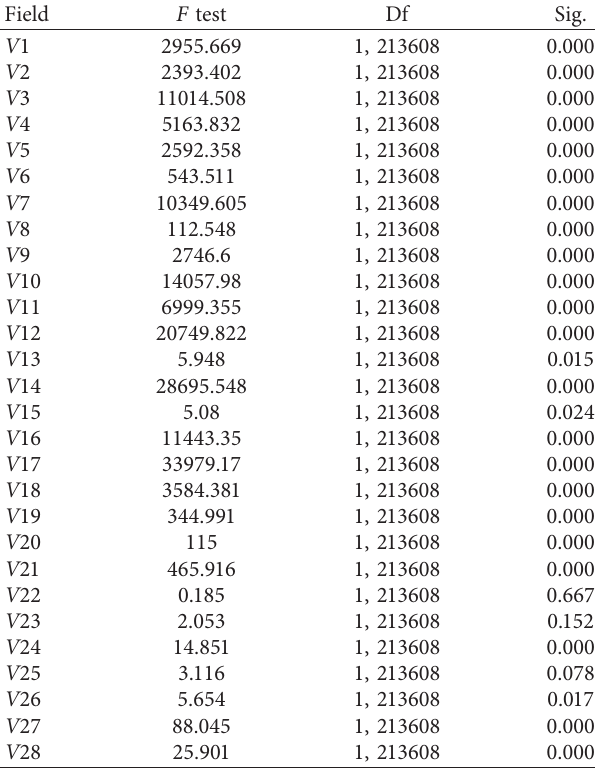
Table 2: The difference of the measurement data by F